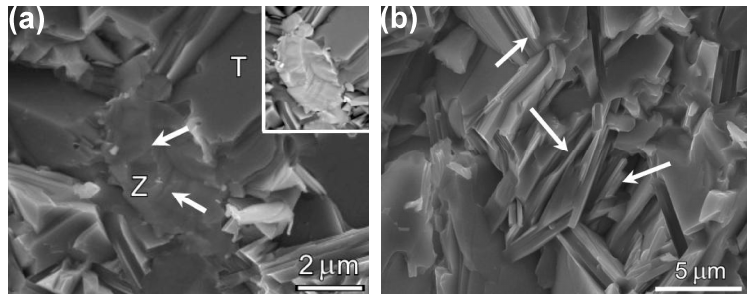
Figure 2. SEM micrographs of the fracture surface of the 20 vol % ZrC/Ti 3 AlC 2 composite. ( a ) Interface between Ti 3 AlC 2 and Zr, the inset: Backscattering image of area pointed with the white arrow; The Letters “T”, and “Z” represent Ti 3 AlC 2 , and ZrC, respectively; ( b ) A crack crossing through Ti 3 AlC 2 grain and ZrC particle [26].